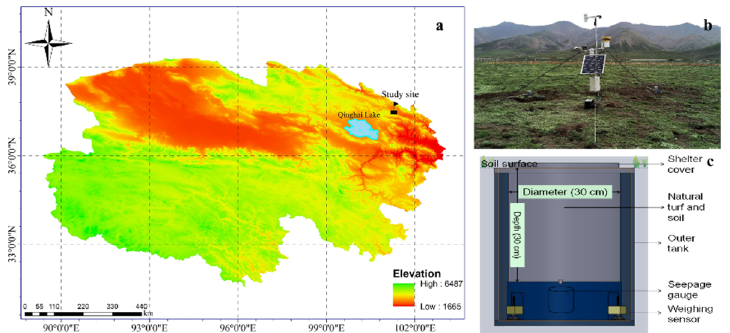
Figure 1. The geographic location of the study site ( a ), a picture of the experiment in the piedmont summer pasture ( b ), and a design sketch of a micro-lysimeter ( c ).